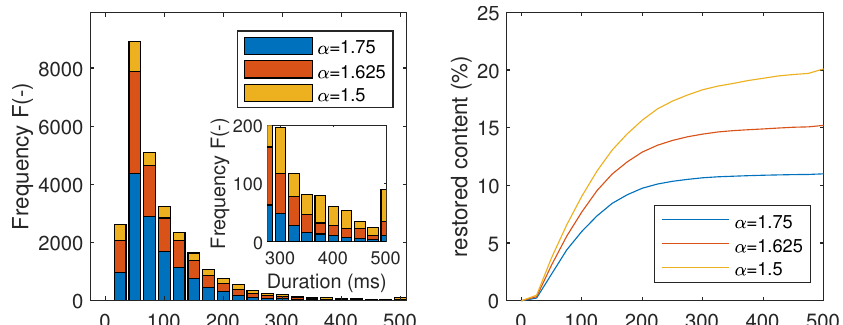
Figure 9. RMSe-algorithm applied on training dataset: ( left ) histogram of anomaly duration and ( right ) overall restoration content of training